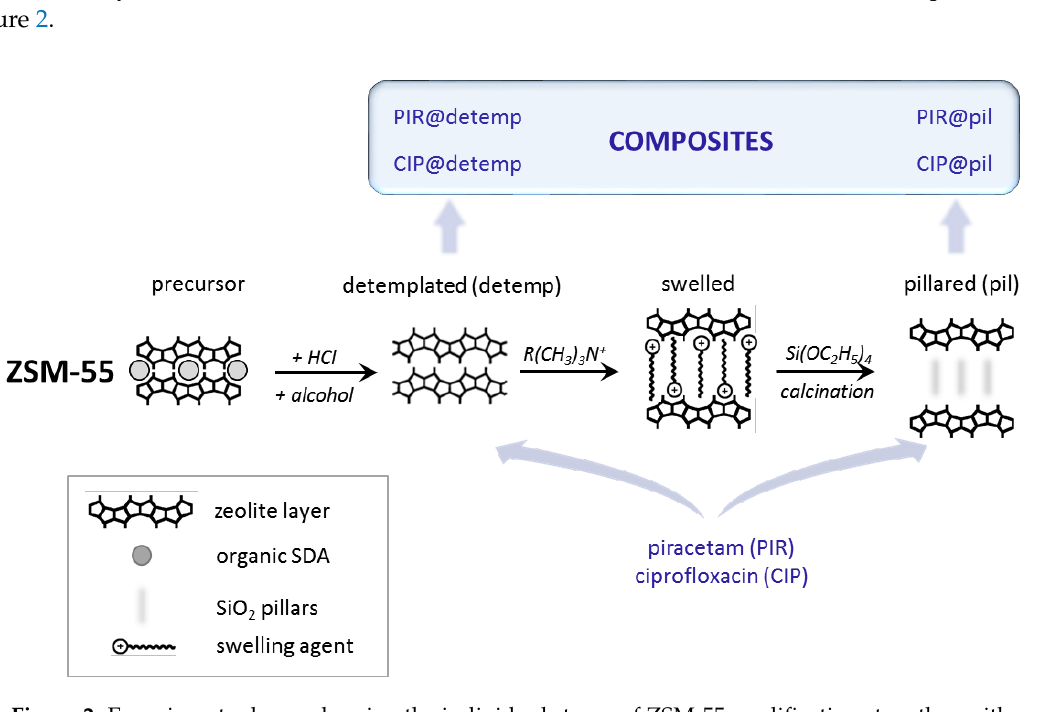
Figure 2. Experiment scheme showing the individual stages of ZSM-55 modifications together with abbreviations used in the manuscript.